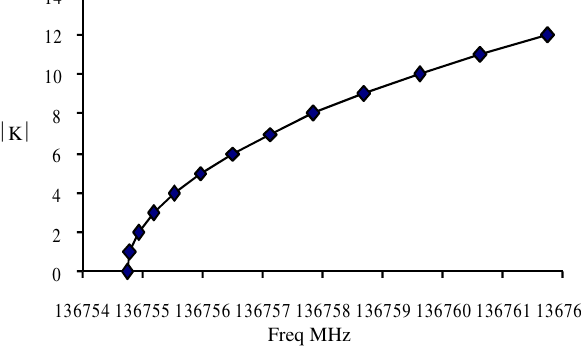
Figure 5. Fortrat diagram for calculated frequencies of (CH